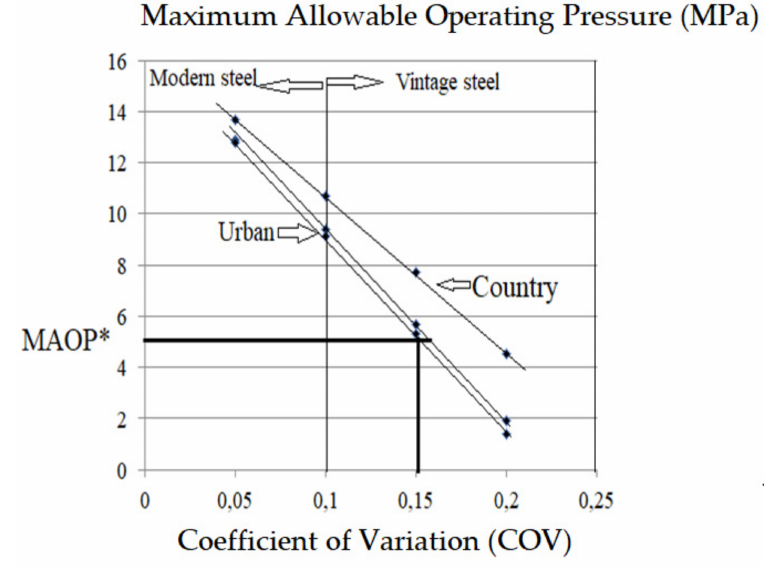
Figure 11. Influence of yield stress COV on MAOP according to locations for modern and vin- tage